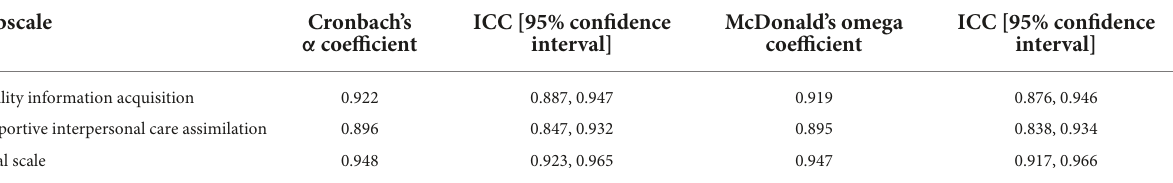
TABLE 4 The reliability of the